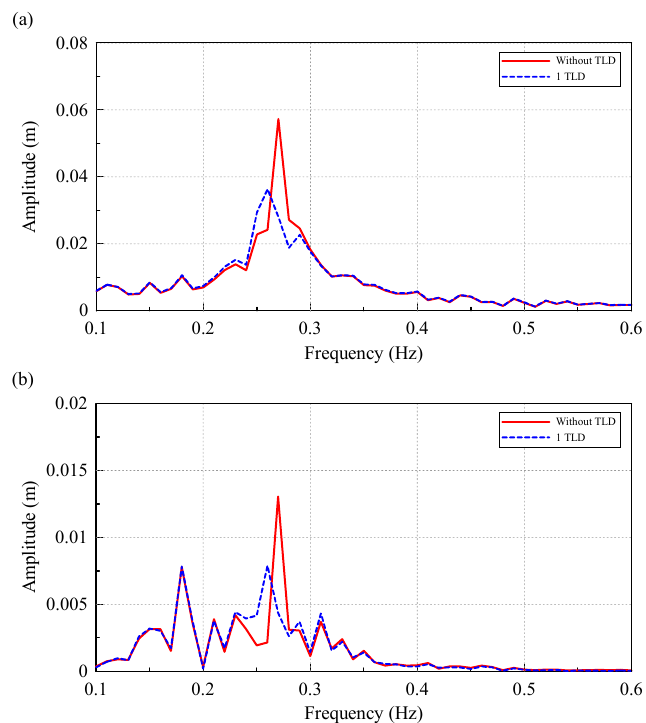
Figure 25. Amplitude spectrum of RNA displacement for an OWT under the DLC 1.2 condition: ( a ) fore-aft movement; ( b ) side-to-side movement.